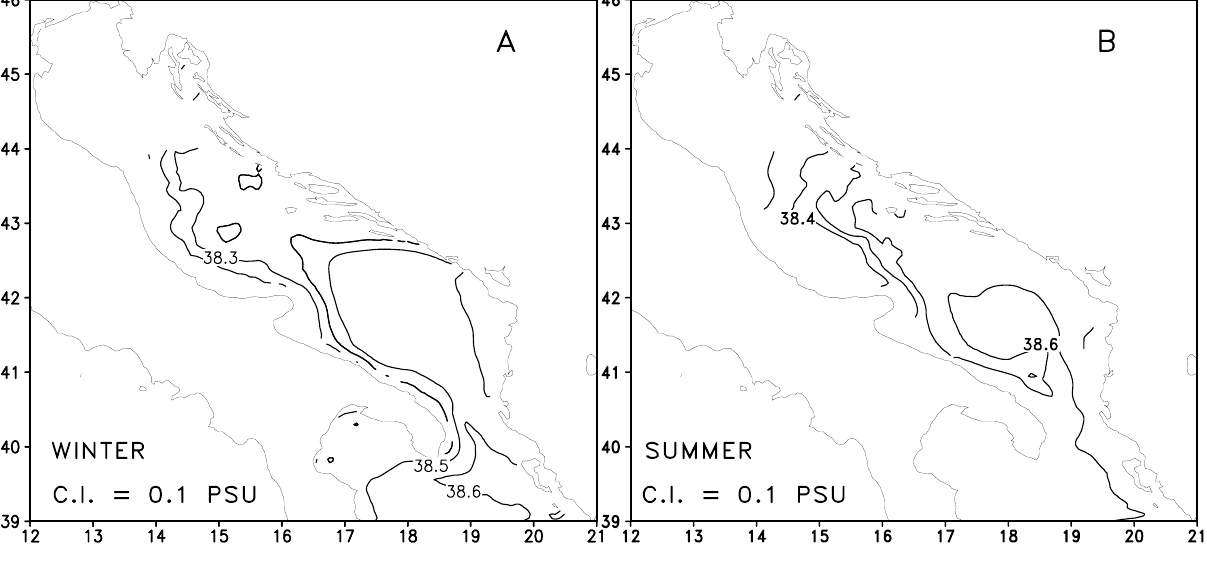
Fig. 10. Adriatic Intermediate Model (AIM). Seasonal salinity fields at 75m depth. (A) : winter, (B) : summer. Contour interval is 0.1psu. Seasons definition as in Artegiani et al. (1997a,